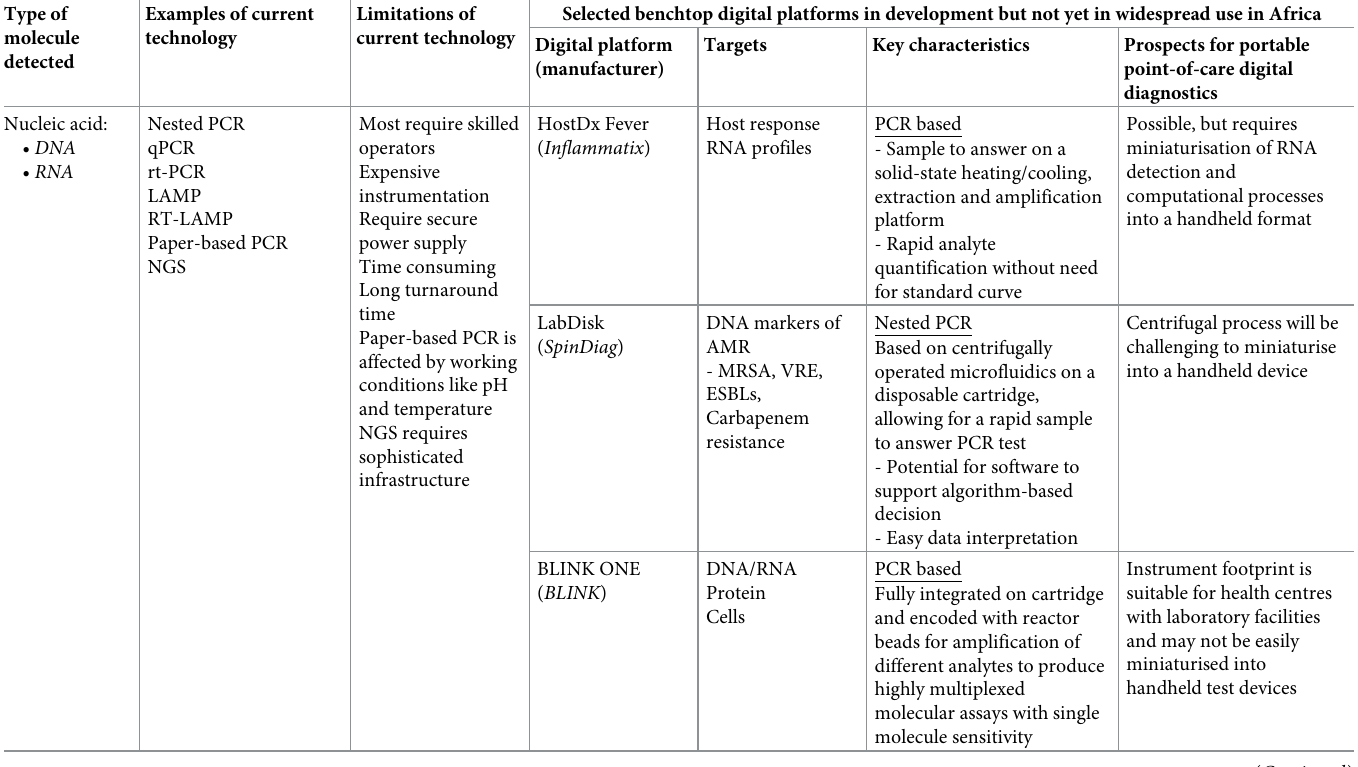
Limitations of current